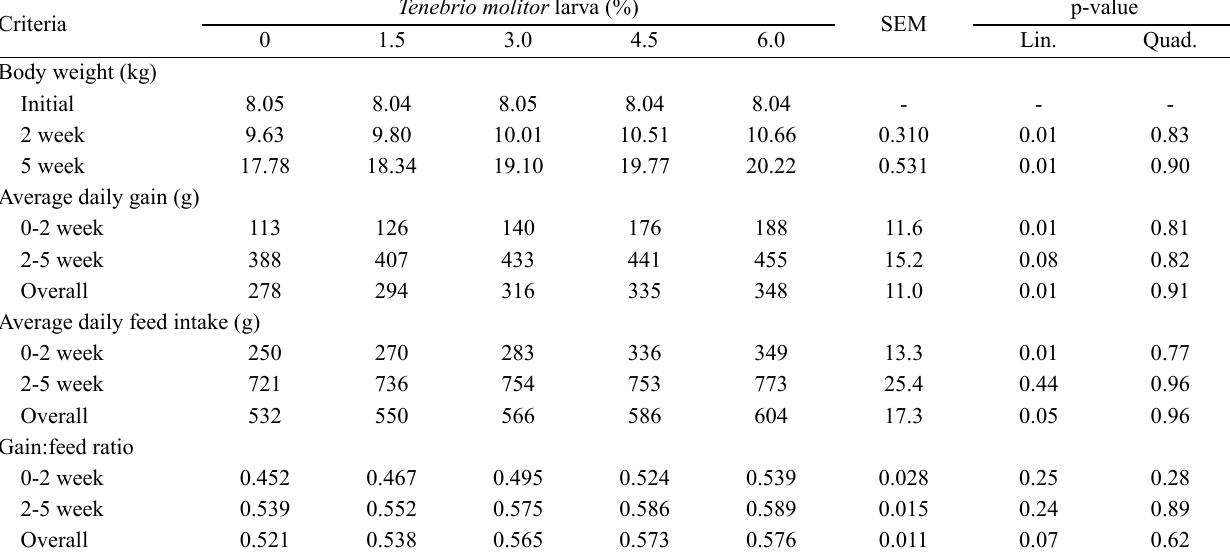
Table 4. Effect of dried mealworm larvae supplementation on growth performance in weaning pigs 1,2